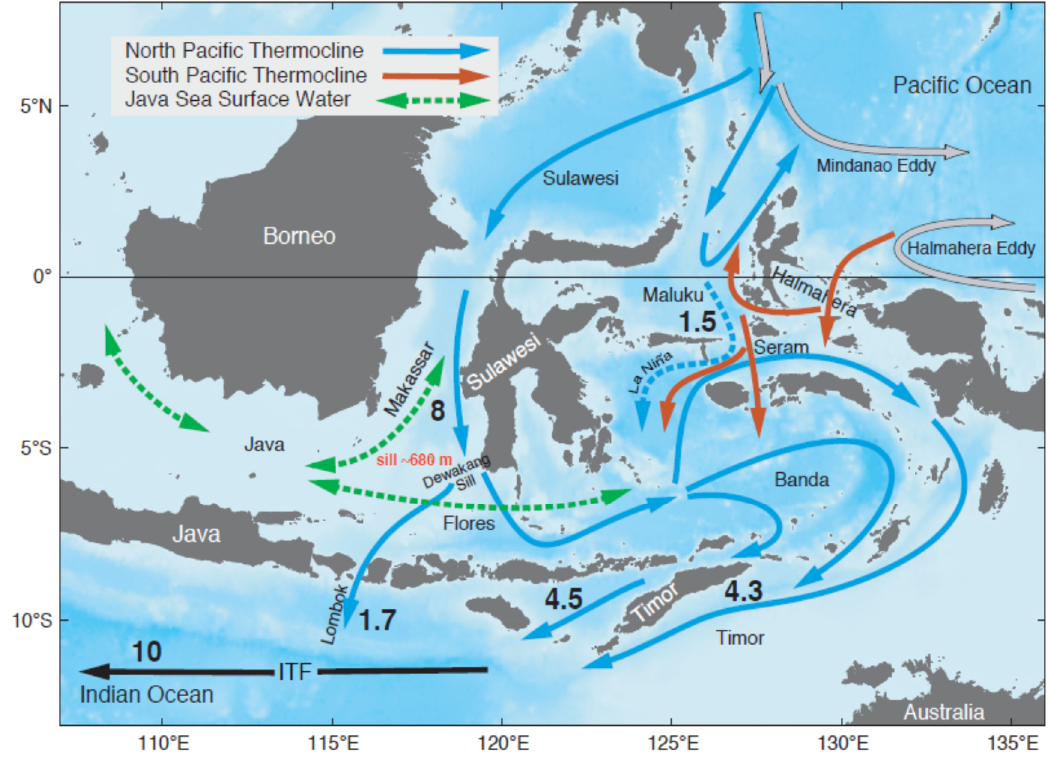
Figure 2. Indonesian throughflow pathways and estimates of the total volume transported (Sv = 10 6 m 3 /sec). Modified from Figure 5 of Gordon